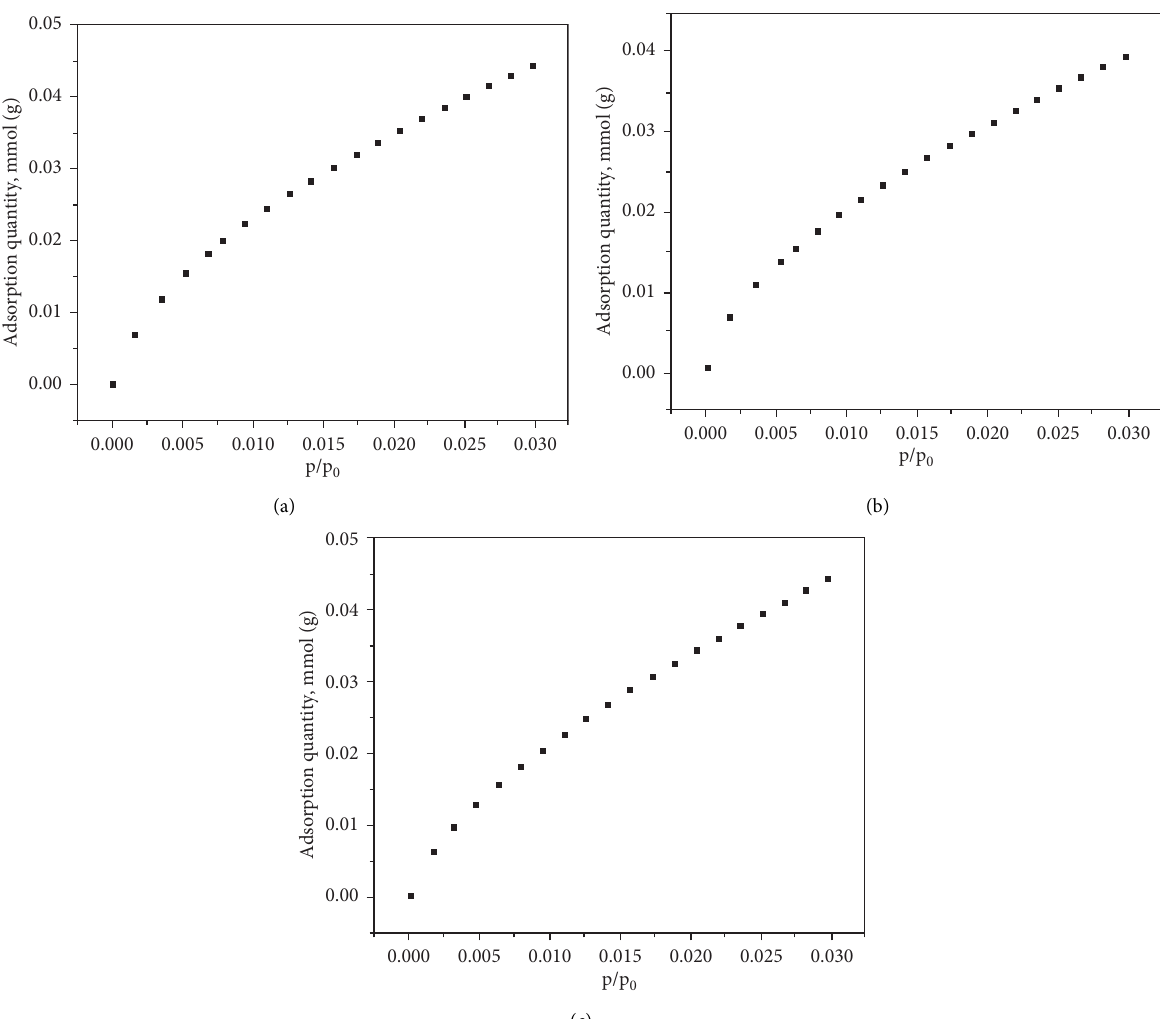
Figure 1: Measured CO 2 adsorption isotherms of three shale samples. (a) Sample 1. (b) Sample 2. (c) Sample 3.